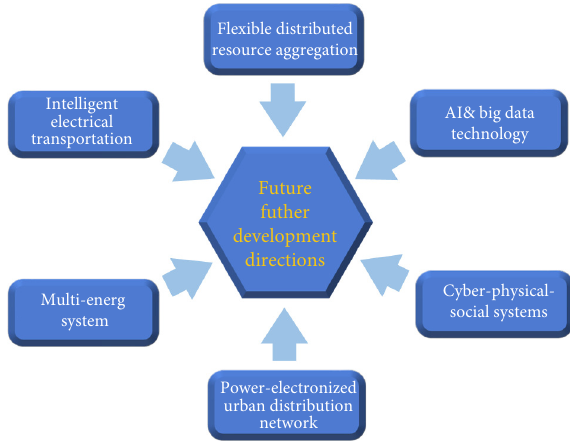
Fig. 6 Future further development research